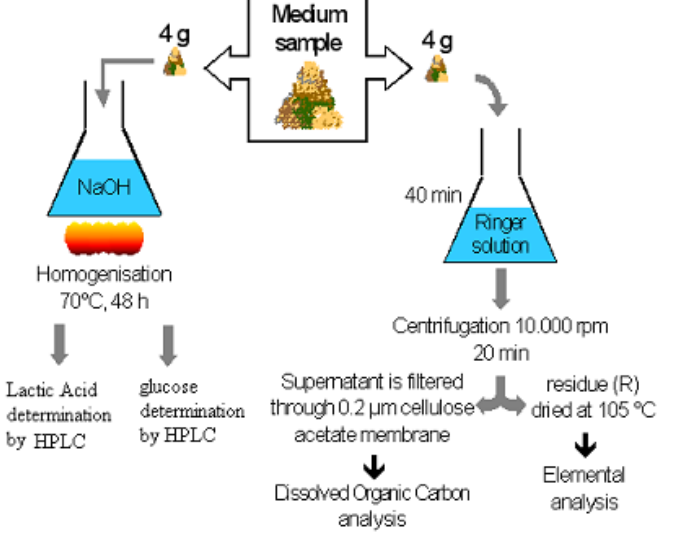
Figure 2. Protocol for by-product extraction and carbon